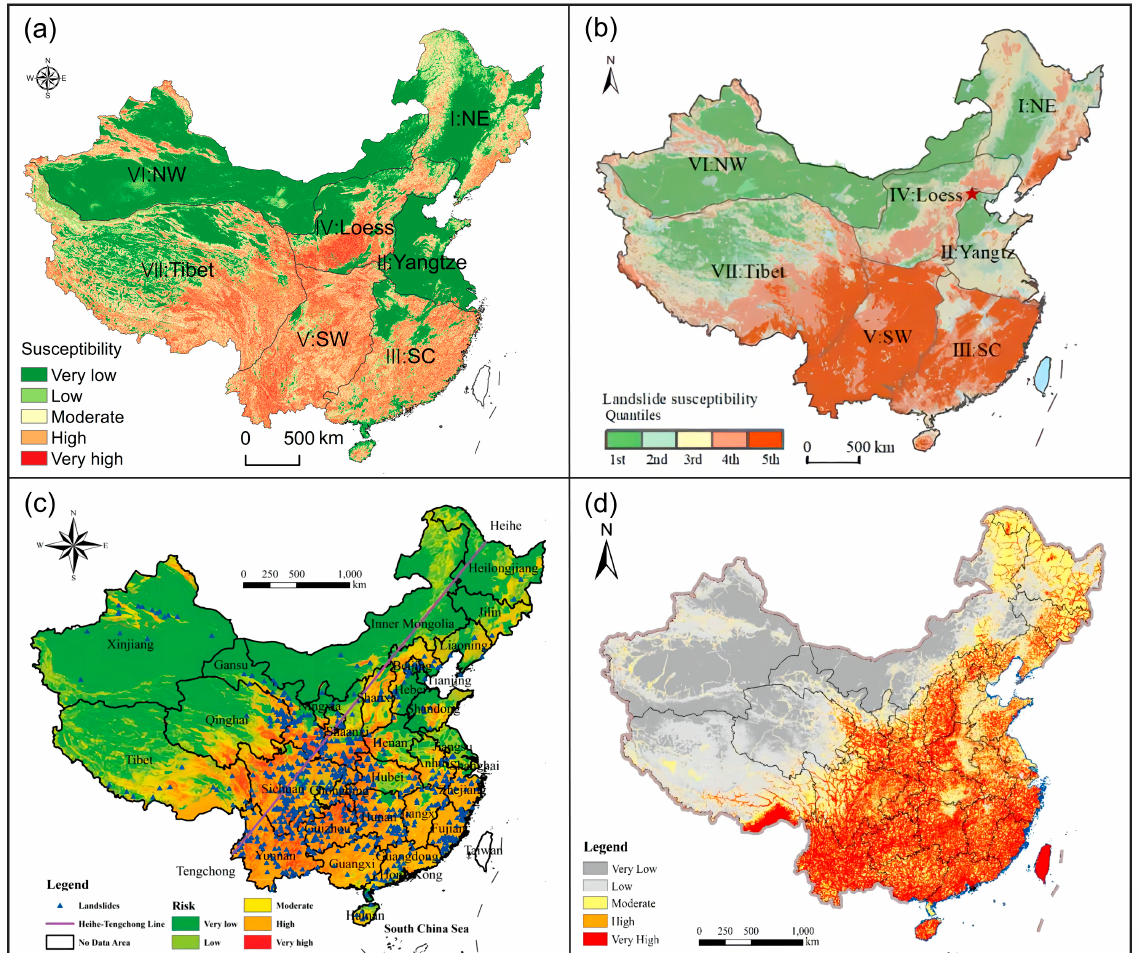
Figure 12. Comparison of results from this study with that of previous research. ( a ) Landslide susceptibility map generated by this paper based on TBMM; similar maps from ( b ) Lin et al. [57]; ( c ) Liu and Miao [99]; ( d ) Wang et al. [10].